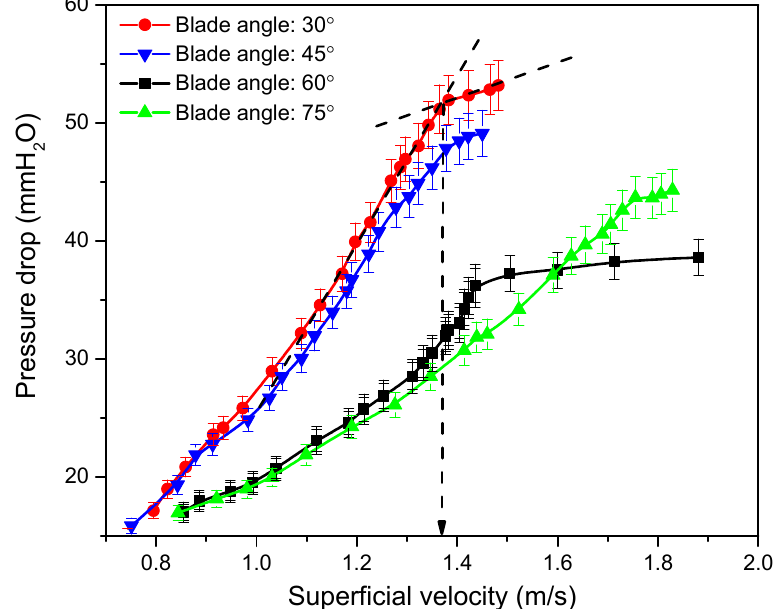
Figure 5. Estimation of U m for different blade angles by plotting ∆(cid:1842) against U sup for bed weight of 750 g.